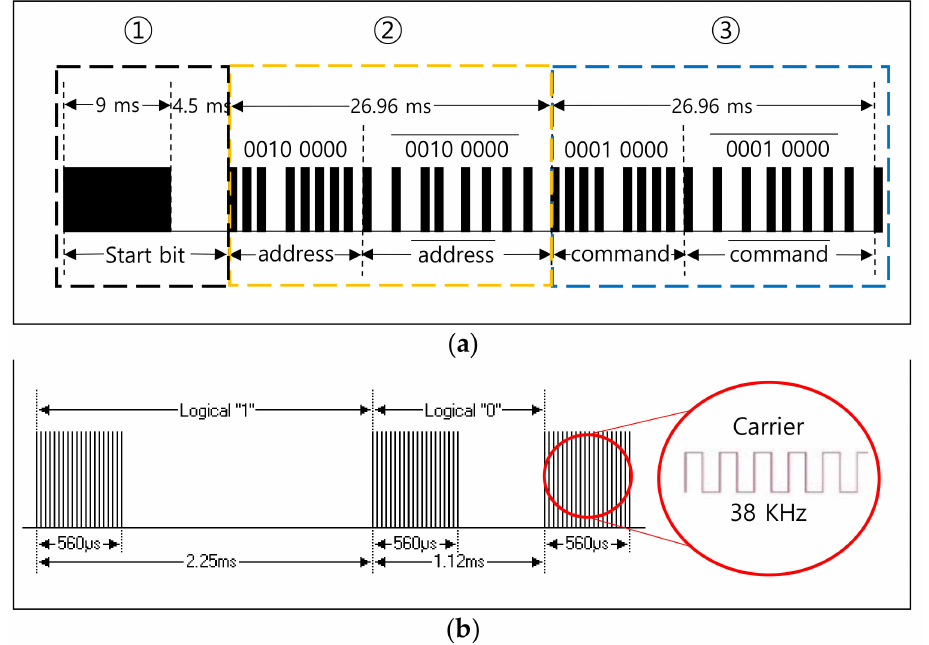
Figure 3. NEC protocol. ( a ) Frame format (example with power button of LG TV remote). ( b ) ‘0 (cid:48) and ‘1 (cid:48) representation.